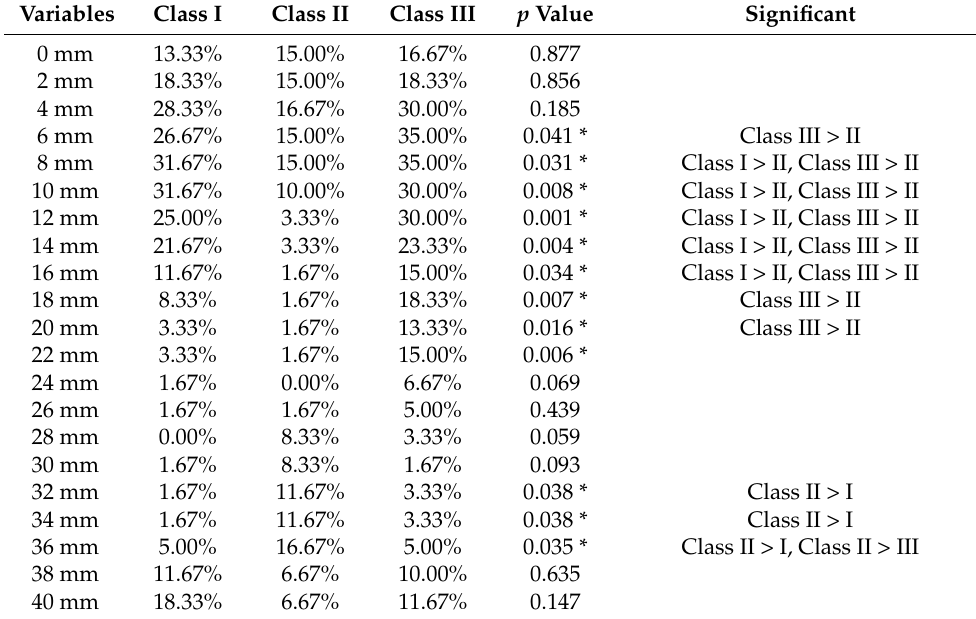
Table 5. From slice 0 (0 mm) to slice 20 (40 mm), the percentage in the buccal bone marrow distance (SBM ≤ 0.8 mm) of skeletal